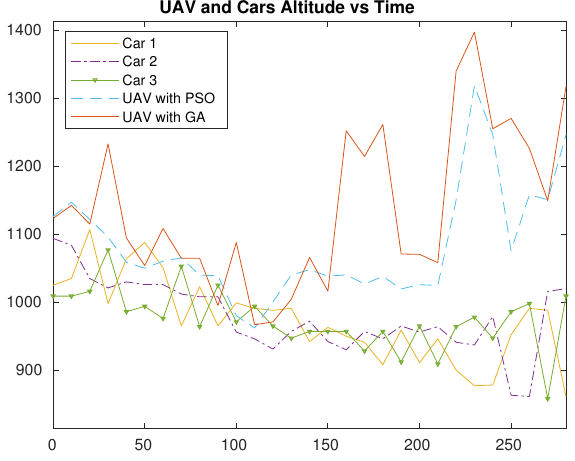
Figure 7. Altitude variations throughout time for the UAV and ground